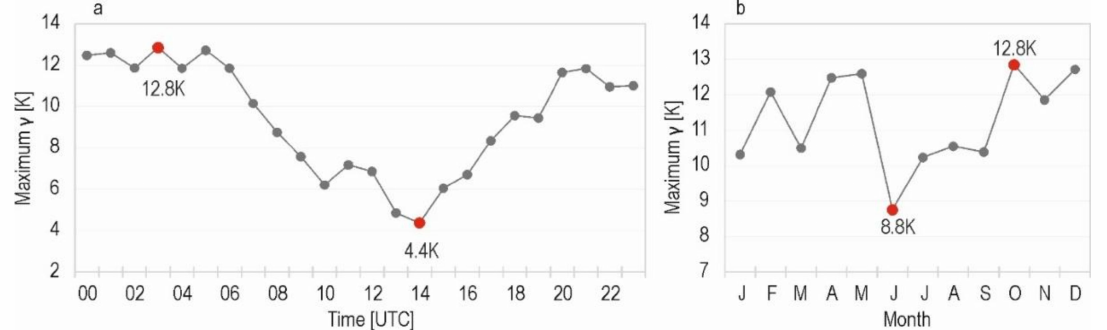
Figure 5. Daily ( a ) and annual ( b ) variability in maximum SBI intensity based on 1 h data. Time: 12 UTC = 13:20 local mean solar